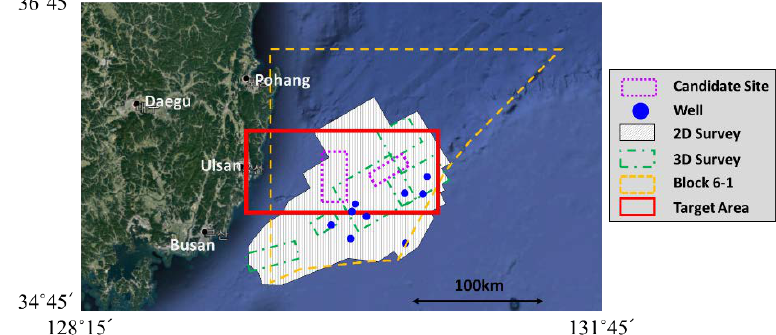
Figure 1. Target area for numerical simulation (source: https://www.google.com/maps).